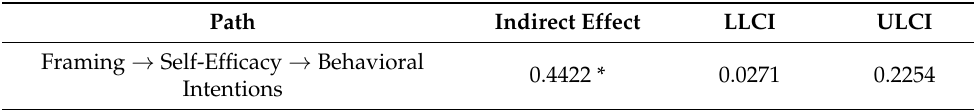
Table 1. PROCESS Macro mediation results. Path Indirect Effect LLCI ULCI Framing → Self-Efficacy → Behavioral 0.4422 * 0.0271 Intentions